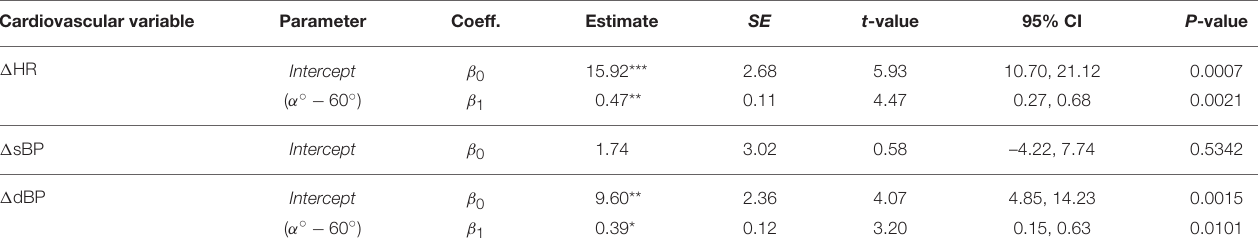
TABLE 1 | Statistical models for 1 HR, 1 sBP, and 1 dBP responses to head-up tilt. Cardiovascular